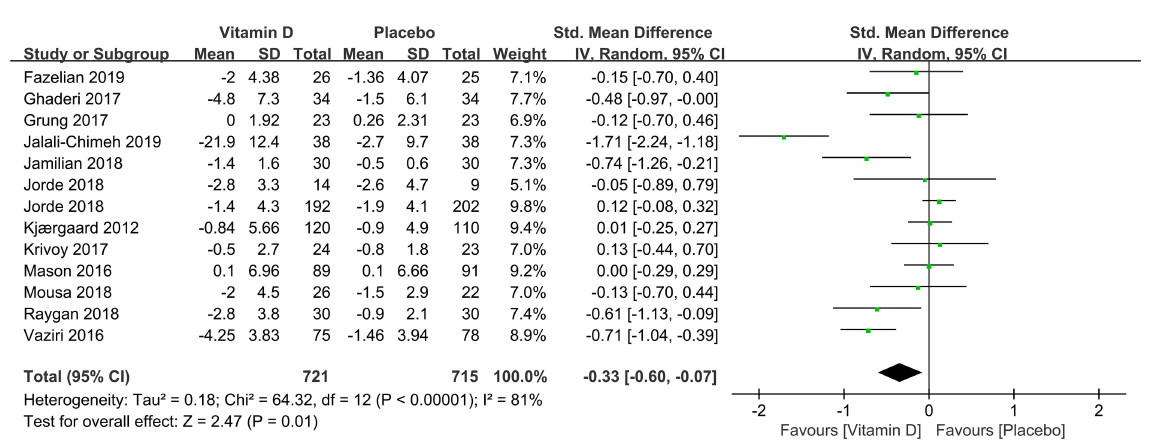
FIGURE3 Forest plot of the correlation between vitamin D and the incidence of depression for population with low vitamin D levels ( < 50 nmol/L).